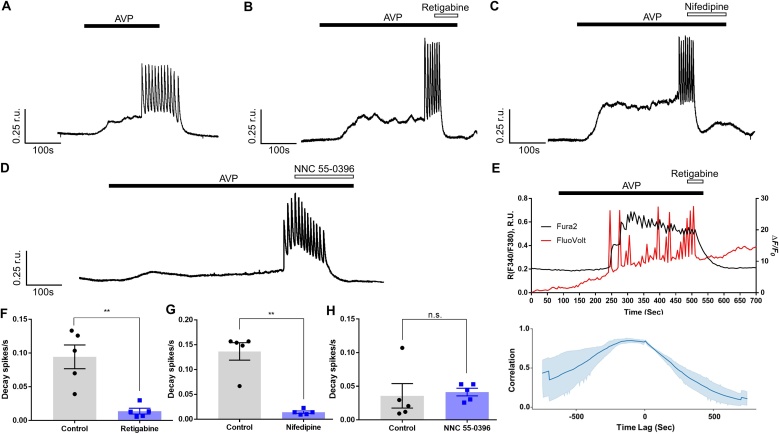
AVP-induced Ca2+ oscillations can be abolished by Kv7 activator, L- and T-type Ca2+ channel blockers. (A) Representative example trace showing Ca2+ oscillations (indicated as F340/F380 ratio units; r.u.) evoked by the physiological concentration of vasoactive hormone, vasopressin (AVP; 100 pM) in A7r5 cells. (B-D) Example traces of AVP-induced Ca2+ transients recorded in the presence of Kv7 channel opener, retigabine (10 μM; B), L-type (nifedipine; 2 μM; C) or T-type (NNC 55-0396; 3 μM; D) Ca2+ channel blockers (as indicated). (E) Upper panel: superimposed are Fura2 ratiometric Ca2+ recording (black) and FuoVolt membrane potential recording (measured as ΔF/F0; red) during application of AVP (100 pM) and retigabine (10 μM) during periods indicated by horizontal bars. Lower panel: Cross correlation of the normalised ratiometric Ca2+ signal with the normalised FluoVolt signal indicated the time lag between the signals at which the peak correlation occurred. (F-H) Bar graphs summarising the effects of retigabine (F), nifedipine (G) or NNC 55-0396 (H) on the AVP-induced Ca2+ spike frequency (spikes/s). Control is the spike frequency in the presence of AVP measured from the onset of the first spike. For quantification of drug effect spike frequency was calculated from the onset of the drug application and until the end of the application of AVP. In panels F-H data are presented as mean ± S.E.M.; n.s., not significant; **P < 0.01 (n = 5).